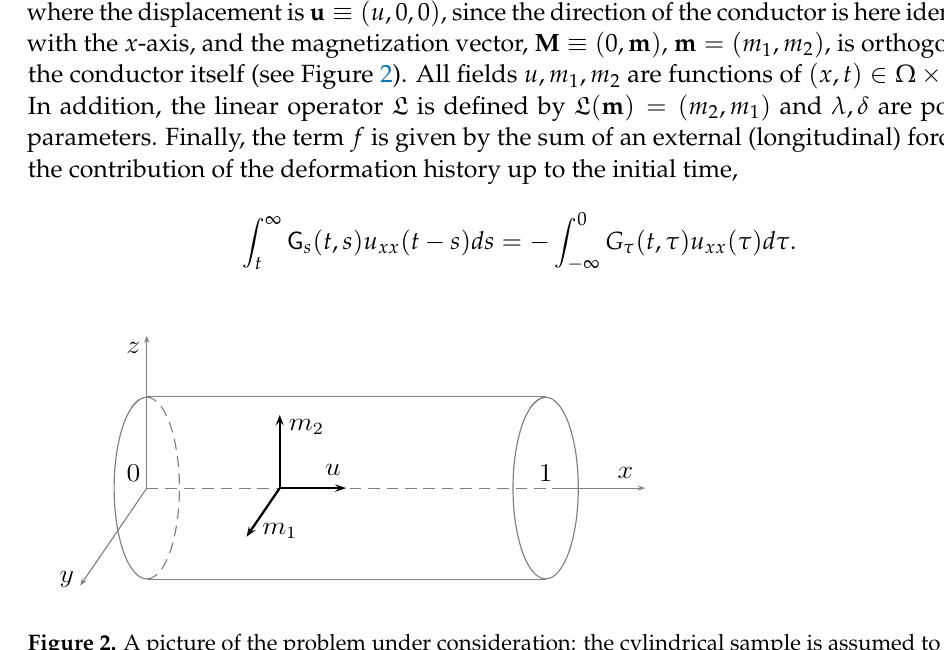
Figure 2. A picture of the problem under consideration: the cylindrical sample is assumed to have a negligible radius compared to its